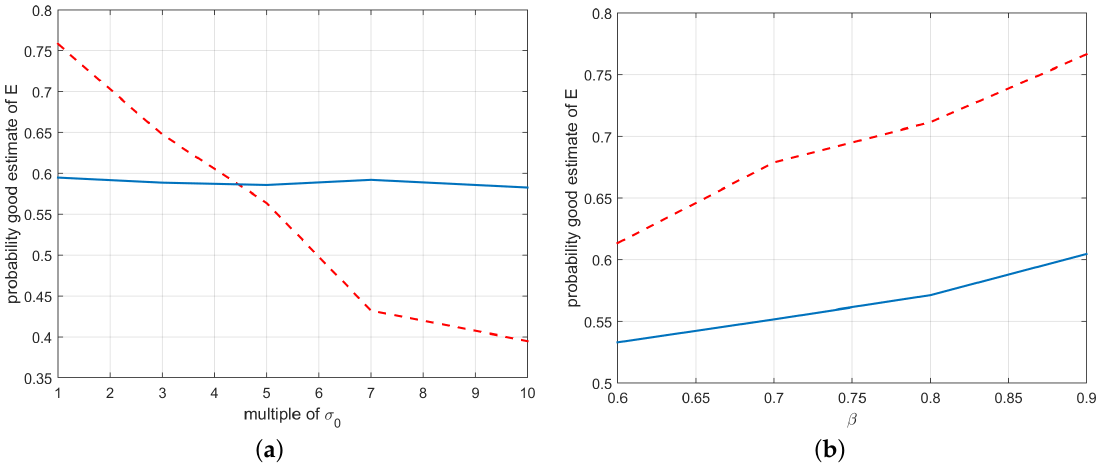
Figure 10. Probability of computing a good estimate of the essential matrix E varying the magnetometer measurement noise level ( a ) and β ( b ), respectively. Comparison of the results obtained with the standard five-point algorithm ( red dashed line), and the two-point algorithm of Section 3.1 ( blue solid